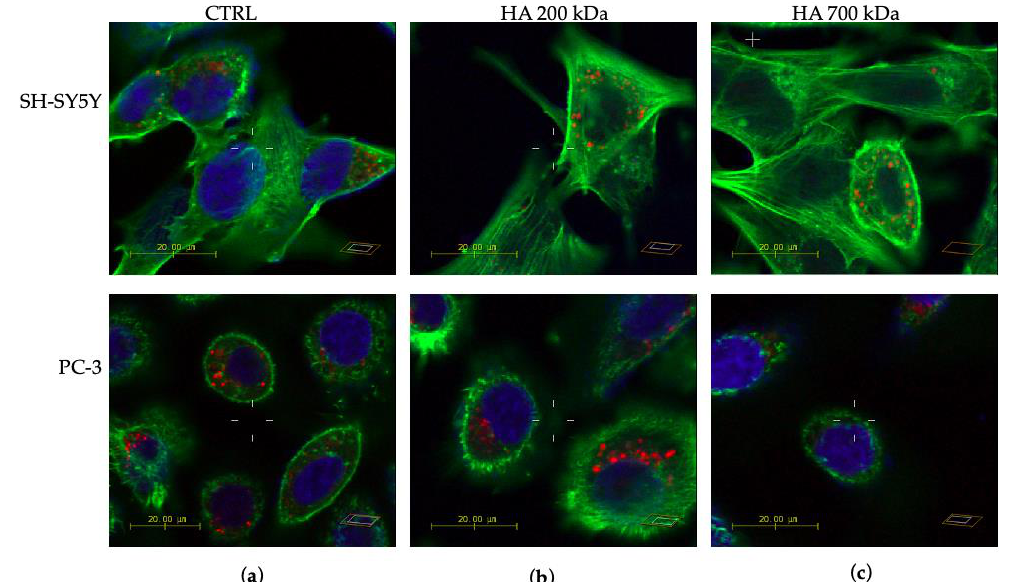
Figure 8. Laser scanning microscopy (LSM) representative micrographs of neuroblastoma (SH-SY5Y)